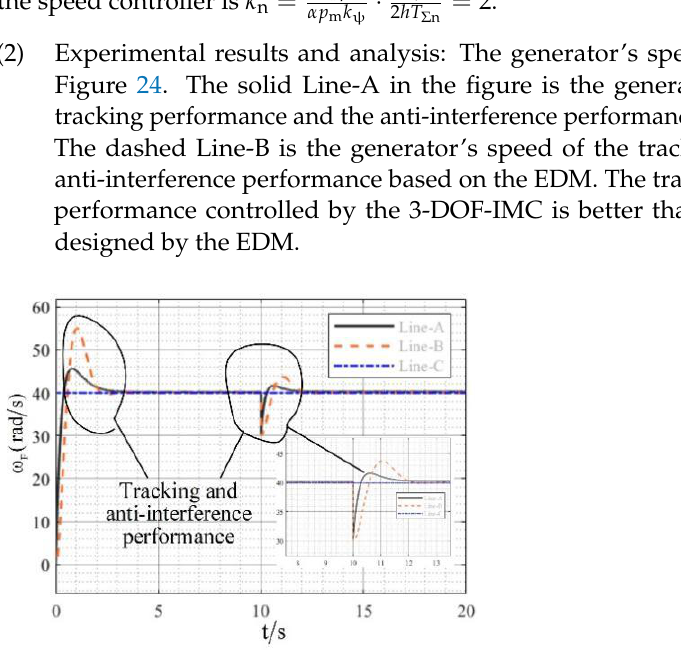
Figure 24. Generator’s speed tracking and anti -interference performance